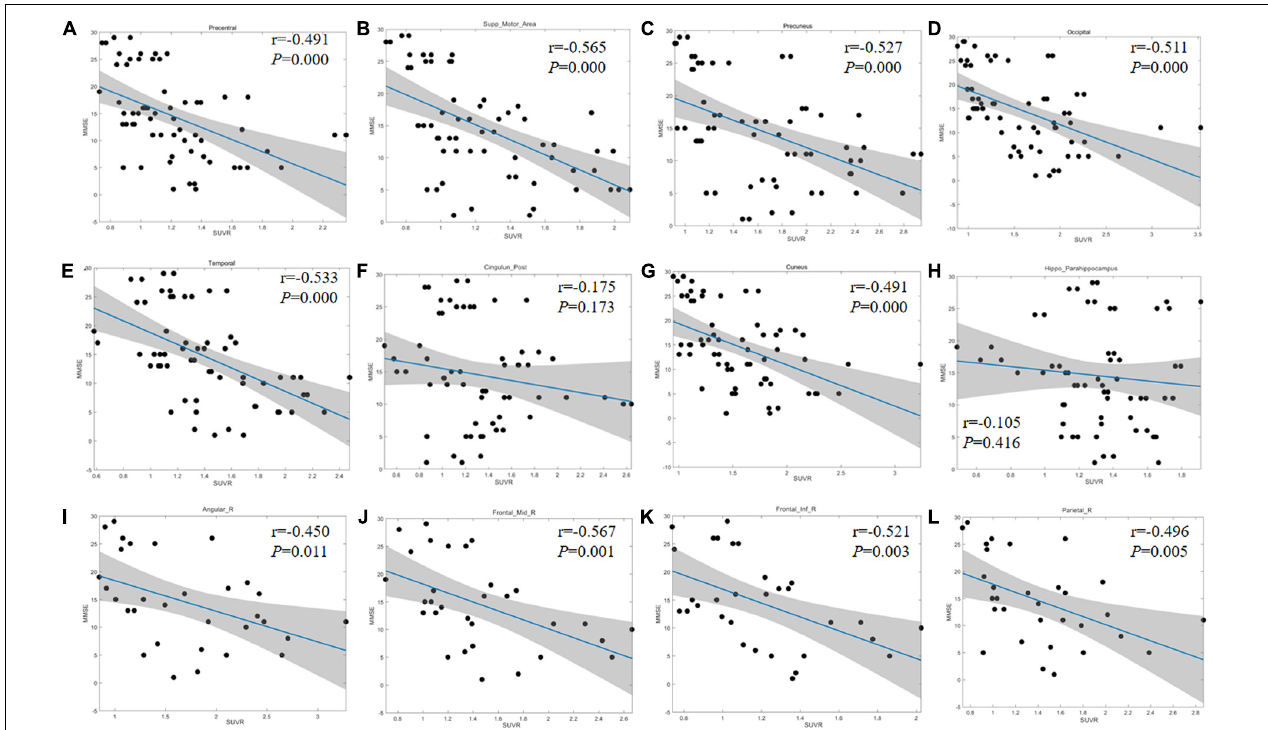
FIGURE 3 | Linear regression results between MMSE score and regional SUVR. (A–H) Correlation coefficient graph of the bilateral precentral gyrus (A) , SMA (B) , precuneus (C) , occipital lobe (D) , lateral temporal lobe (E) , PCG (F) , cuneus (G) , and hippocampus (H) . (I–L) Correlation coefficient graph of the right side of angular gyrus (I) , FGm (J) , FGi (K) , and parietal lobe (L) . The gray area shows the 95% confidence interval area. The blue solid lines refer to the mean fitting curves. SMA, supplementary motor area; PCG, posterior cingulate gyrus; FGm, middle frontal gyrus; FGi, inferior frontal